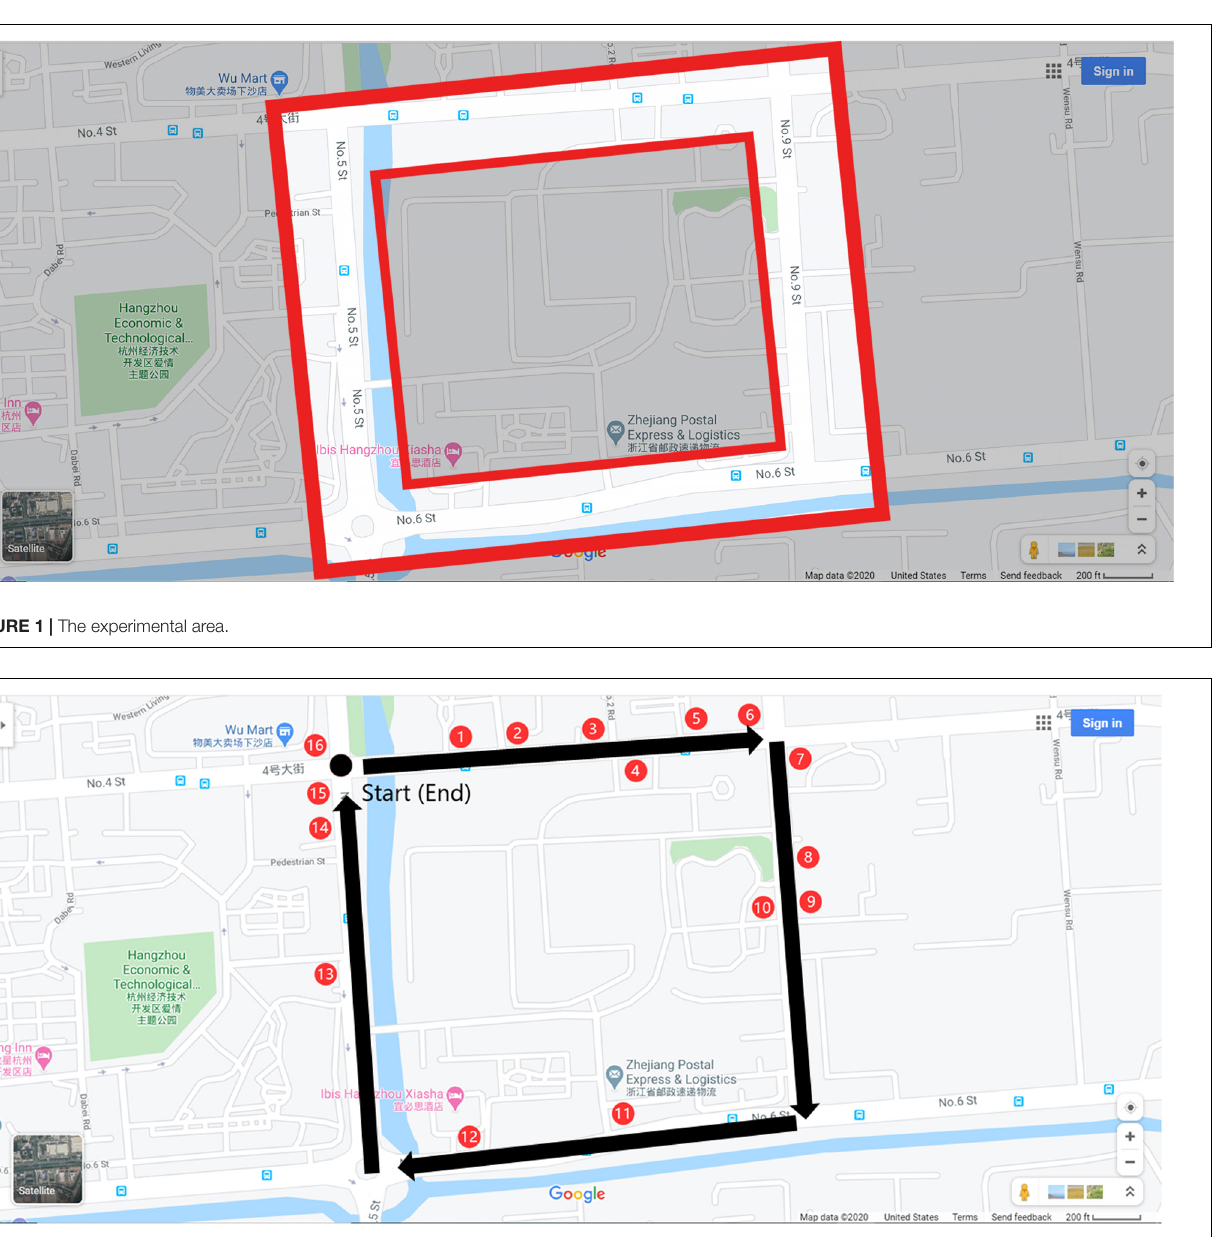
FIGURE 2 | The path through the environment is identified by the superimposed black arrows, and the 16 red ovals shows each landmark’s position (they are not present during